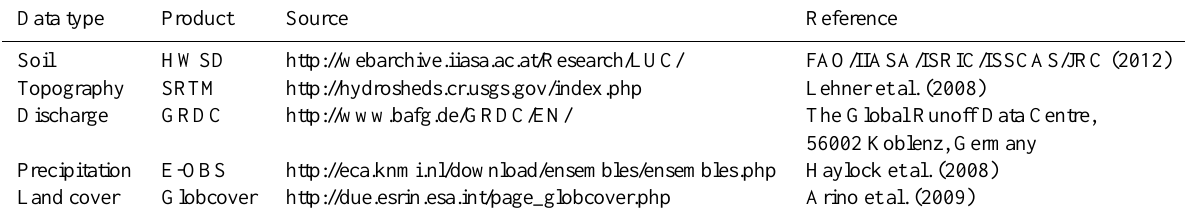
Table 2. Overview of the used